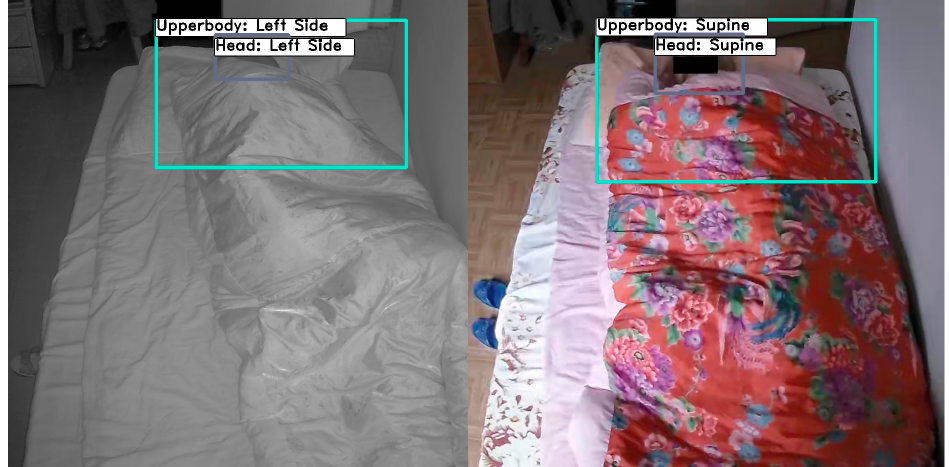
Figure 13. Sleep posture detection on real-life data. The left column shows images in IR mode and the right column shows in RGB mode. the right column shows in RGB mode.